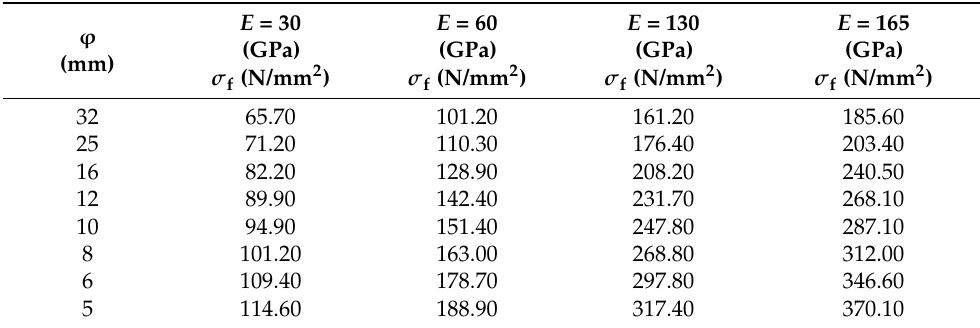
Table 6. Stresses in reinforcement for maximum allowable bar diameter calculated with VBA proce- dure for crack width